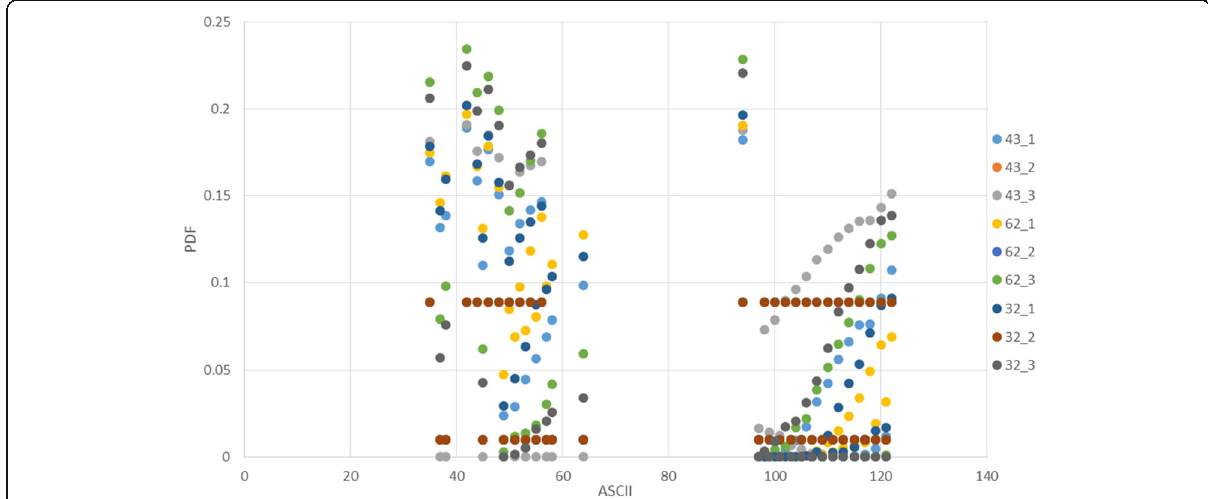
Fig. 3 Probability density function